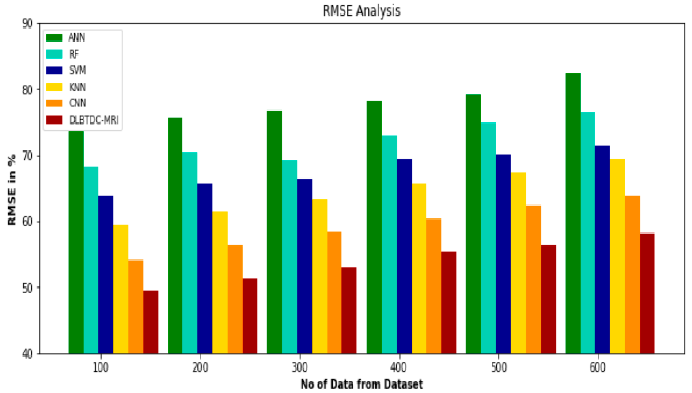
Table 4. RMSE analysis of DLBTDC-MRI method with existing system.